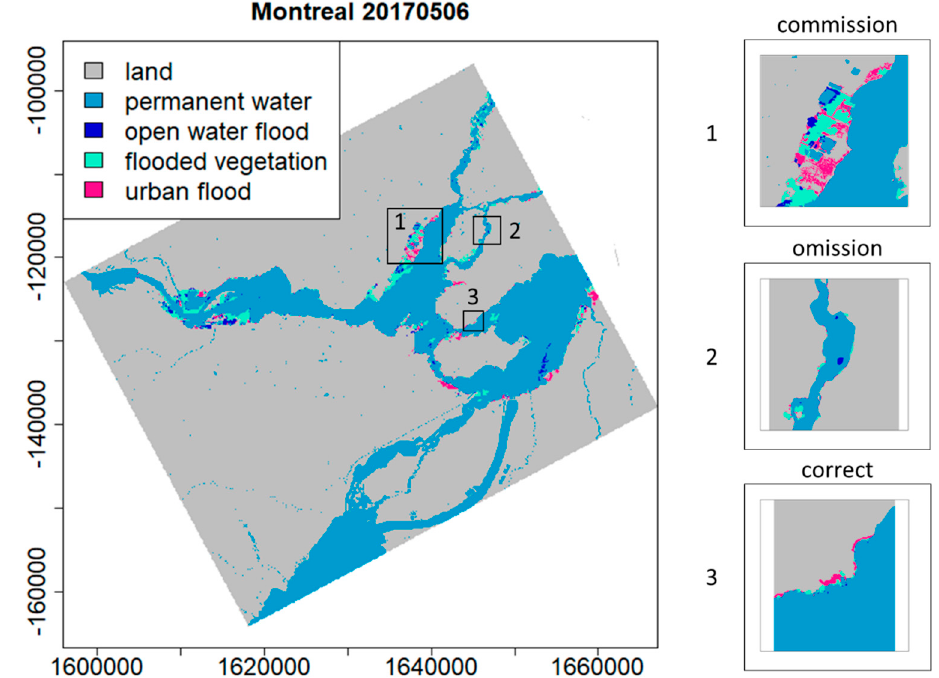
Figure 4. RS2 flood map from May 6, 2017 used to approximate water levels along urban shorelines, with examples of adjacent flood-filled urban areas using Lidar DEM data. On individual dates, examples of known errors of commission, omission, as well as correctly mapped urban flooding according to independent National Aerial Surveillance Program (NASP) and Citizen Geographic Information (CGI) data are shown in boxes 1–3.